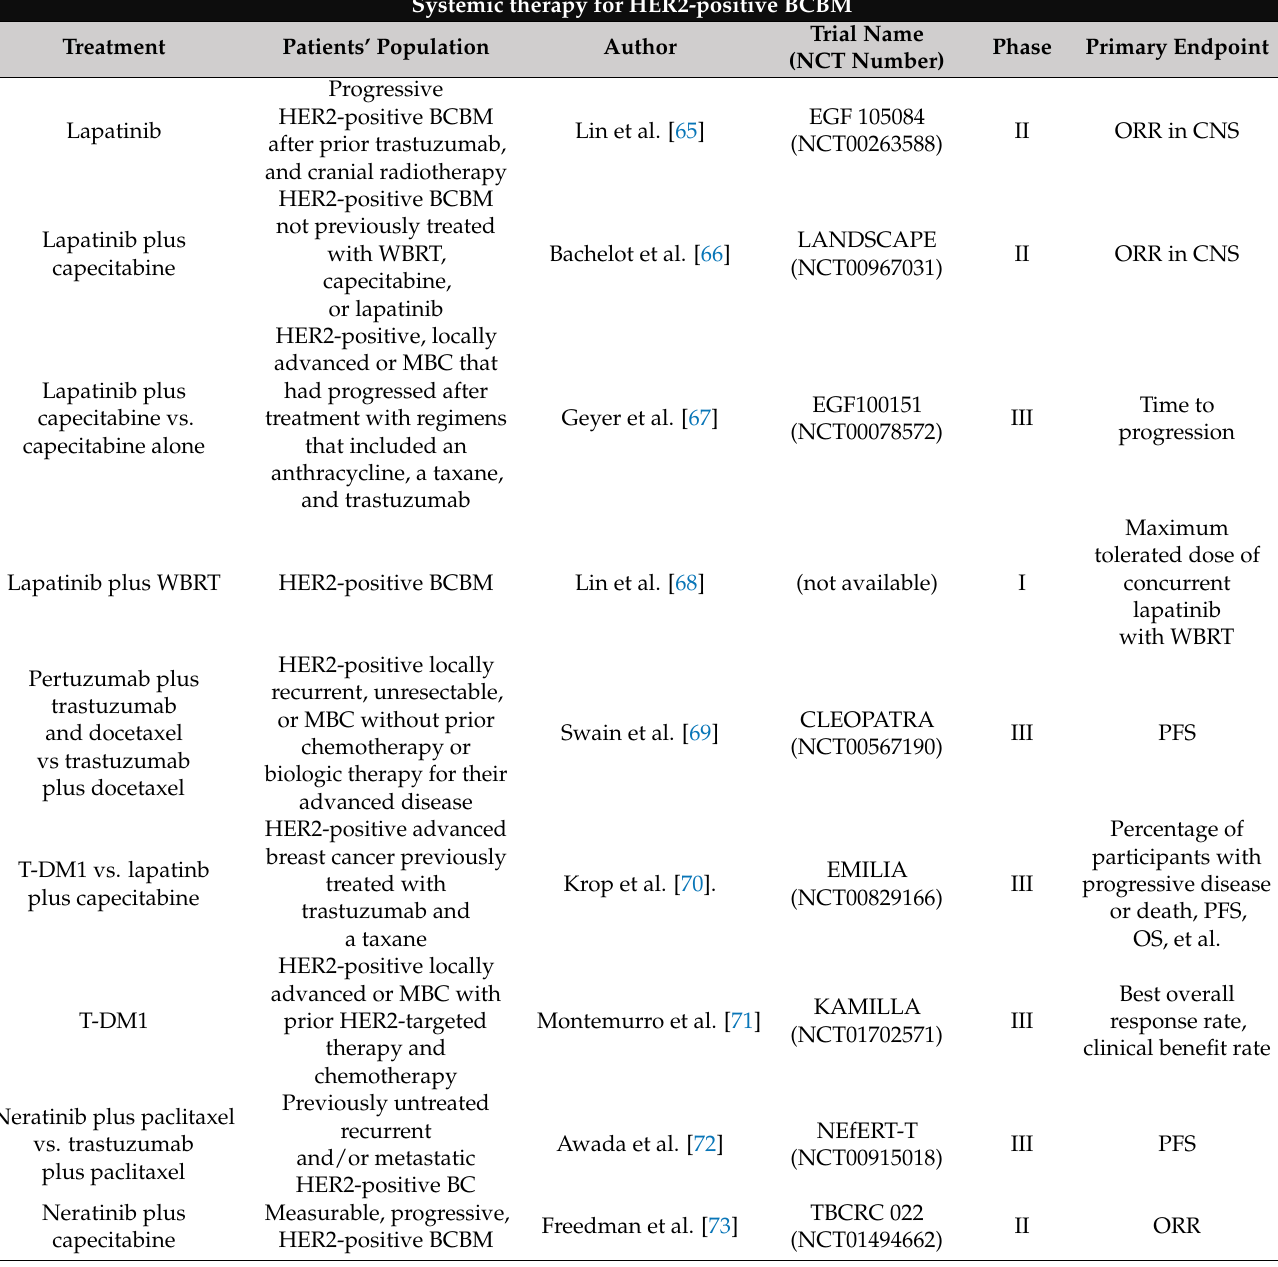
Table 2 (major clinical trials) and Table S2 (other clinical trials) show the main clinical trials in systemic therapy according to subtype. Table 2. Major clinical trials in systemic therapy for BCBM according to